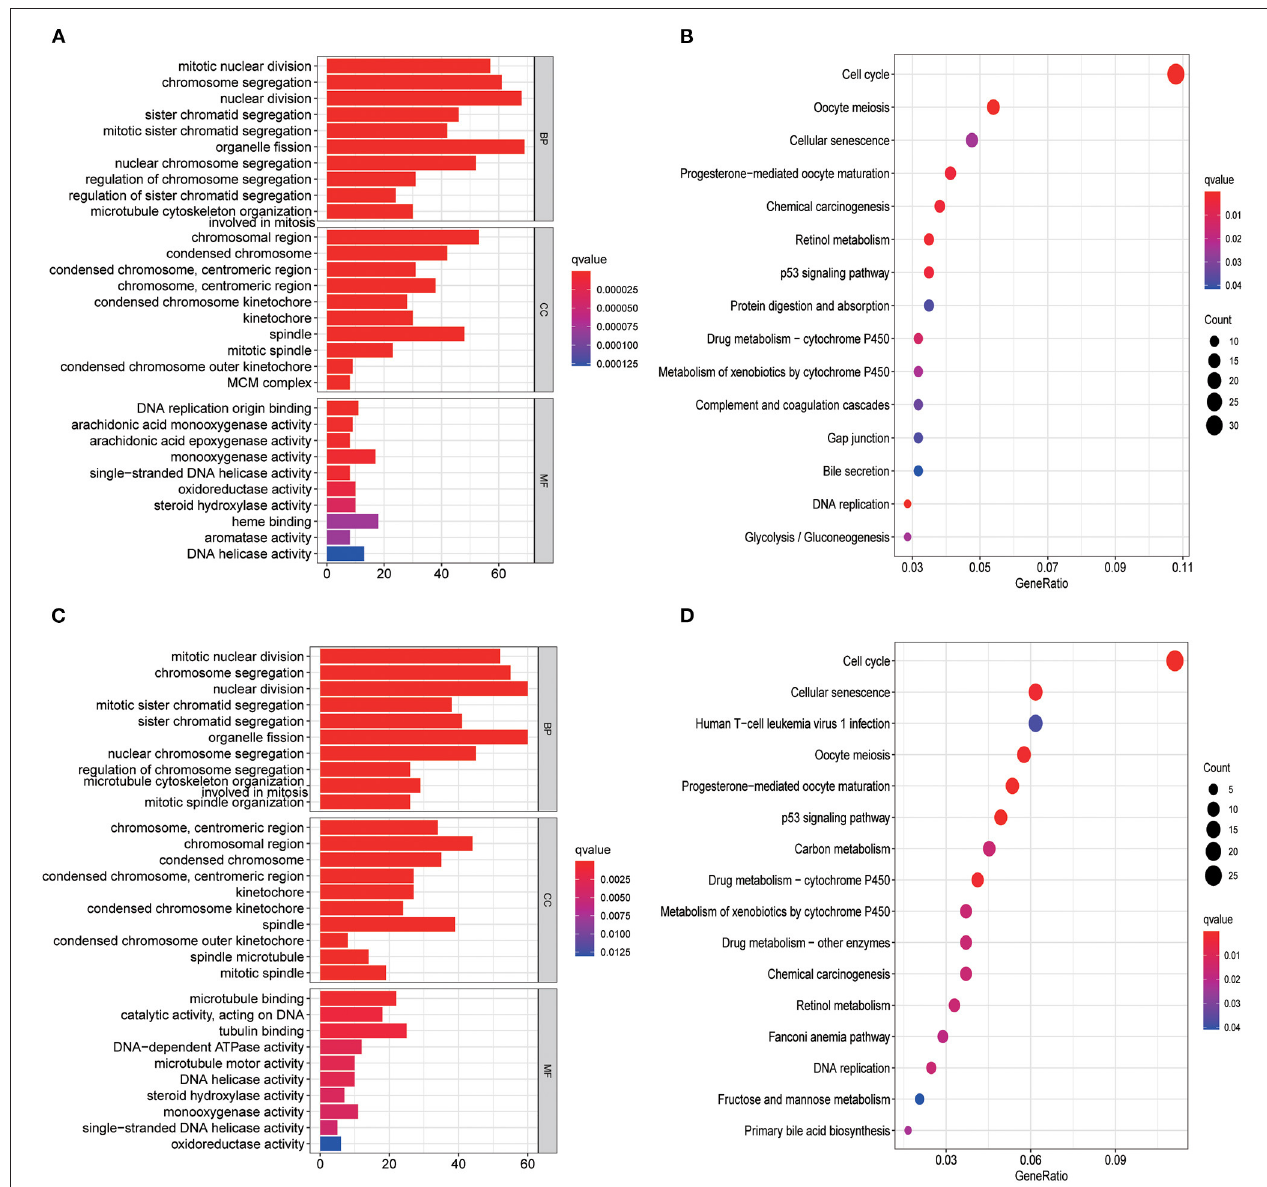
FIGURE 6 | Representative results of GO and KEGG analyses. GO enrichment and KEGG pathways in the TCGA set (A,B) and ICGC set (C,D)